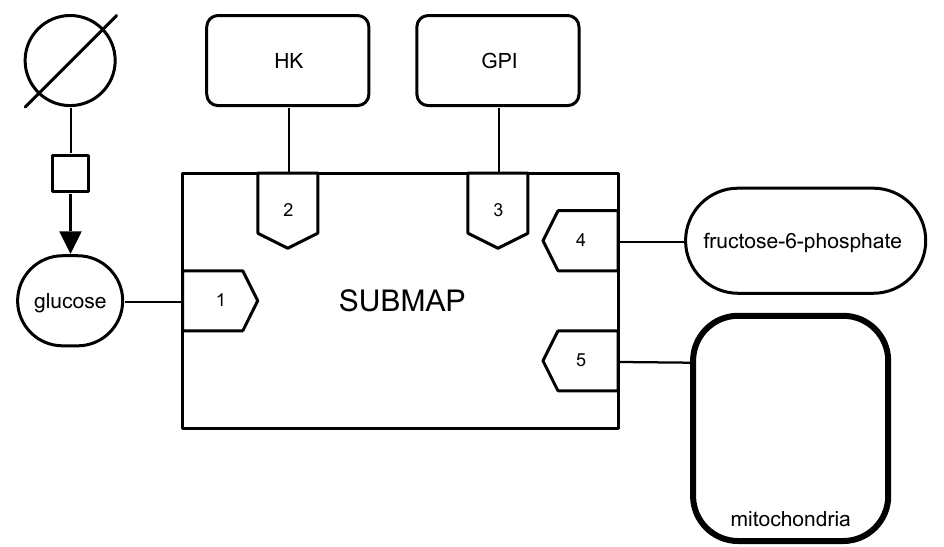
Figure 2.60: Example of a submap encapsulating processes that transform glucose into fructose-6-phosphate. The map enclosed by the submap is shown in Figure 2.61 on the next page, whose tags are referred to by the submap terminals decorating the present submap